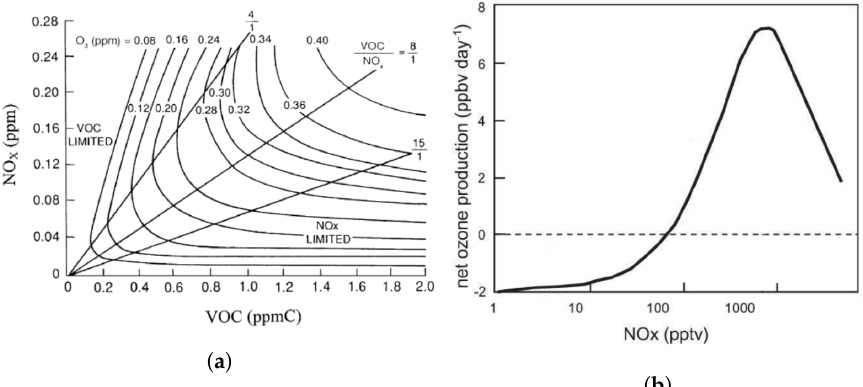
Figure 13. ( a ) Example isopleth diagram displaying peak ozone concentrations calculated from various initial concentrations of NO x and a specified VOC mixture, using the US EPA empirical kinetic model [143]. Reprinted with permission from Jenkin et al. [142]. Copyright 2022, Elsevier. ( b ) Variation of net ozone production efficiency with NO x concentrations, with magnitudes reflect- ing clean free tropospheric conditions (low VOC/NO x ratio). Reprinted with permission from Monks et al. [140]. Copyright 2022, Royal Society of Chemistry,